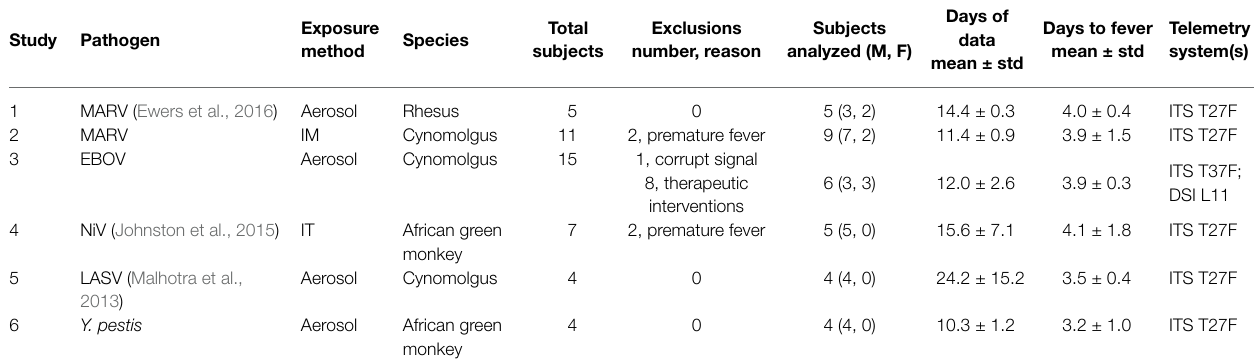
TABLE 1 | Summary of non-human primate studies